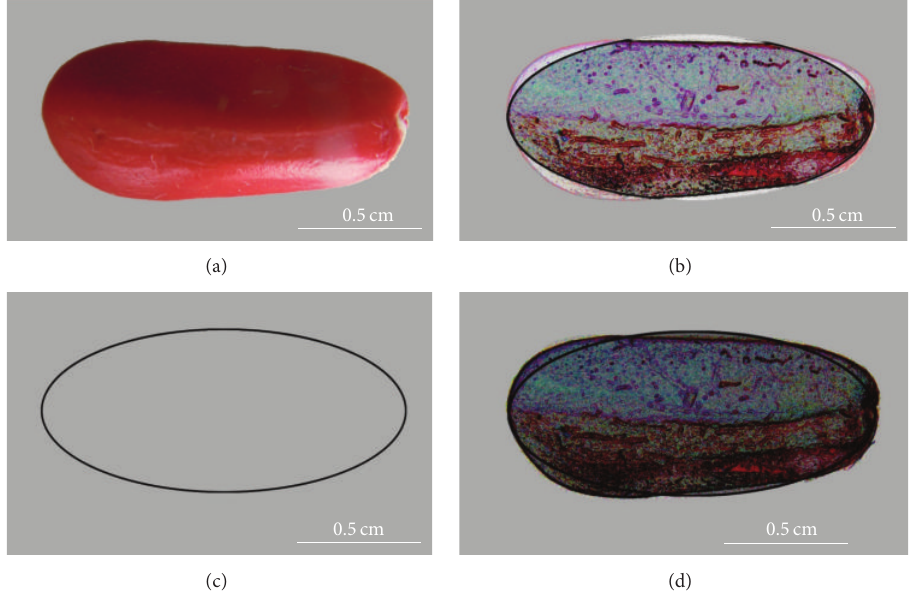
Figure 2: The image represents a seed of Magnolia sp. (a) and the ellipse (c). Shared regions are represented in (b) and the total (shared plus nonshared) in (d). 𝐽 index is the ratio between shared regions and the total: 𝐽 = ( area ( C )/( area ( C ) + area ( D ))) × 100 , where C represents the common region and D the regions not shared. Scale bar represents